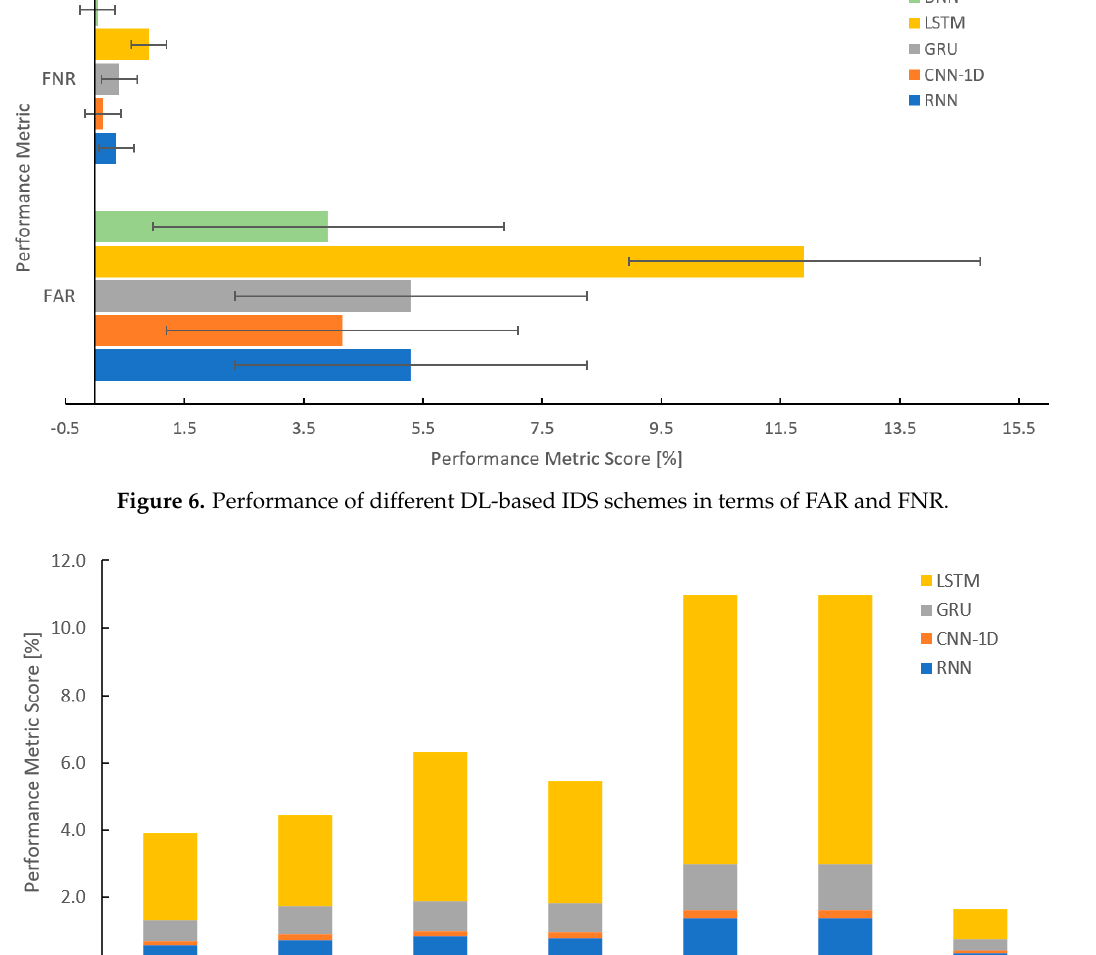
Figure 7. Improvement in DNN’s performance comparing other DL-based schemes.